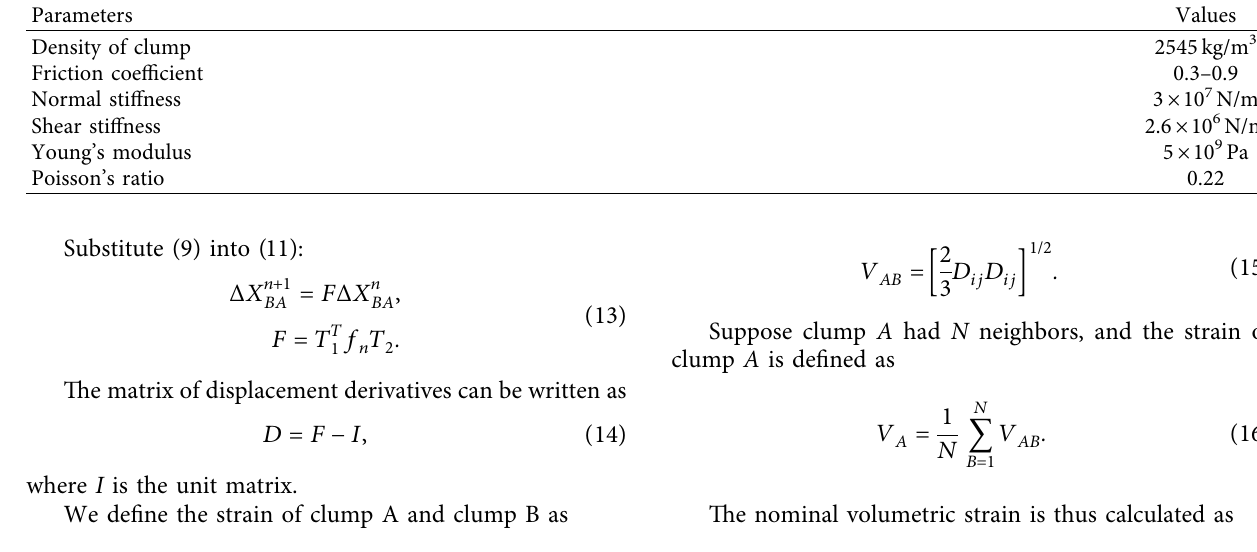
Table 2: Computational parameters of